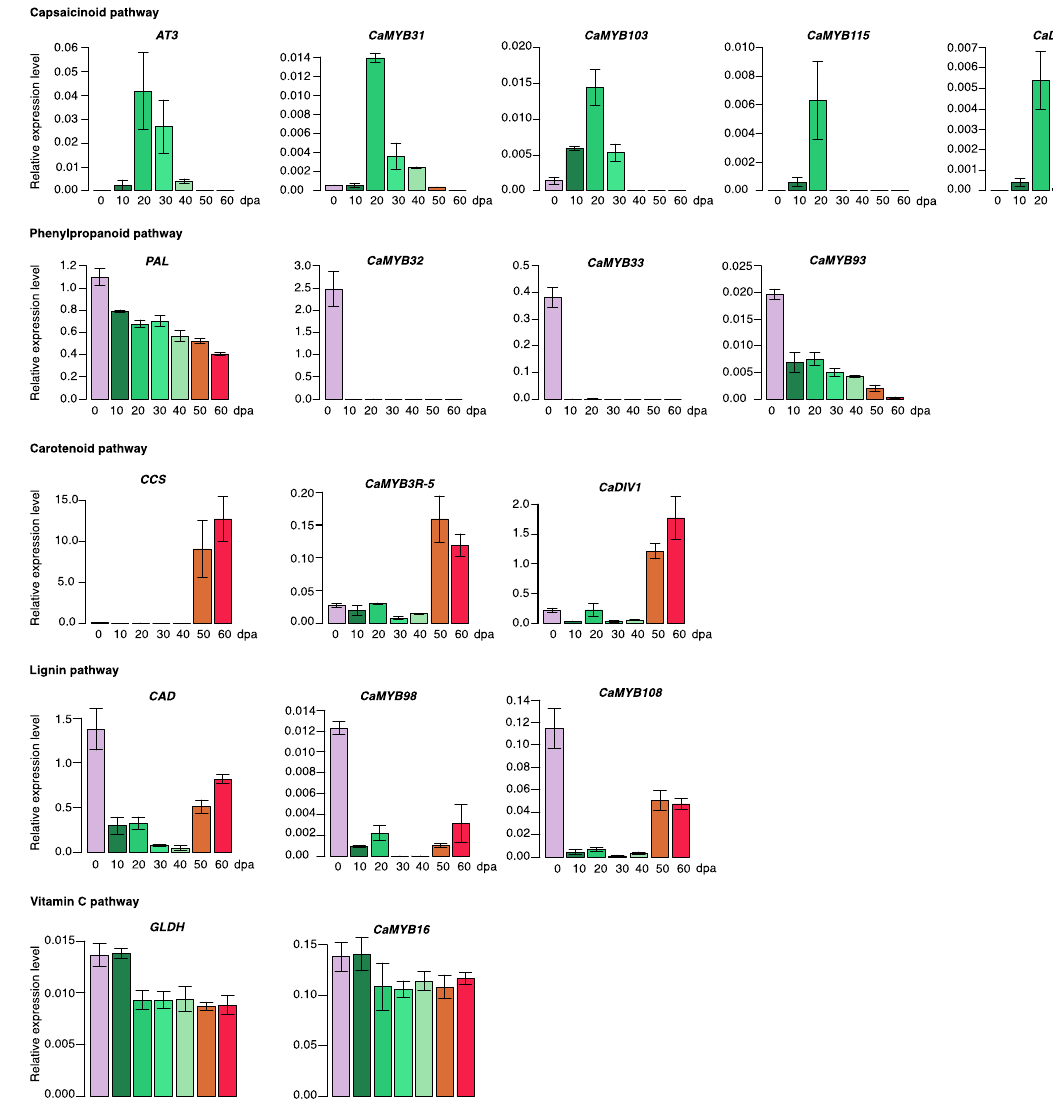
Figure 7. RT-qPCR of the expression profile of AT3 (capsaicinoid pathway), PAL (phenylpropanoid pathway), CCS (carotenoid pathway), CAD (lignin pathway), and GLDH (vitamin C pathway) structural genes and their putative CaMYB regulators. The relative expression level was analyzed in flower (0 dpa; days post-anthesis) and in chili pepper fruit at 10, 20, 30, 40, 50, and 60 dpa. AT3 : Acyltranferase ; PAL : Phenylalanine ammonia lyase ; CCS : Capsanthin-capsorubin synthase ; CAD : Cinnamyl alcohol dehydrogenase ; GLDH : L-galactono-1,4-lactone dehydrogenase . The data points represent the means of three biological replicates ± SD. See Table S4 for primers sequence details.